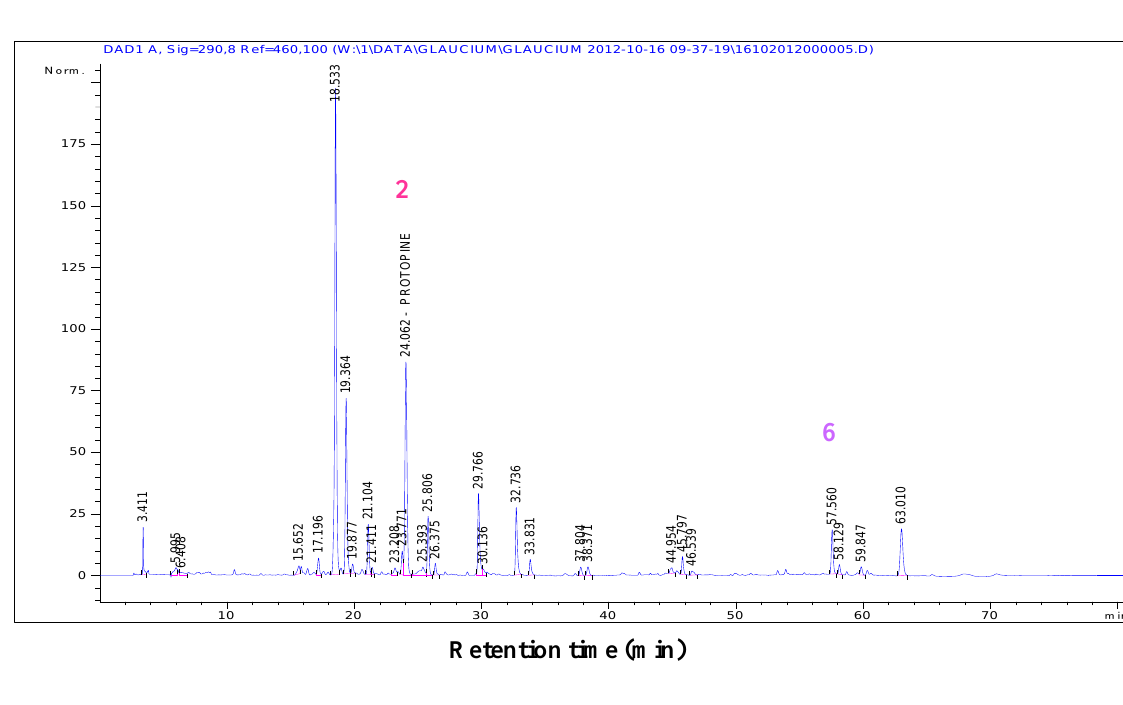
Figure 2. Molecular structure of identified alkaloids in the root alkaloid